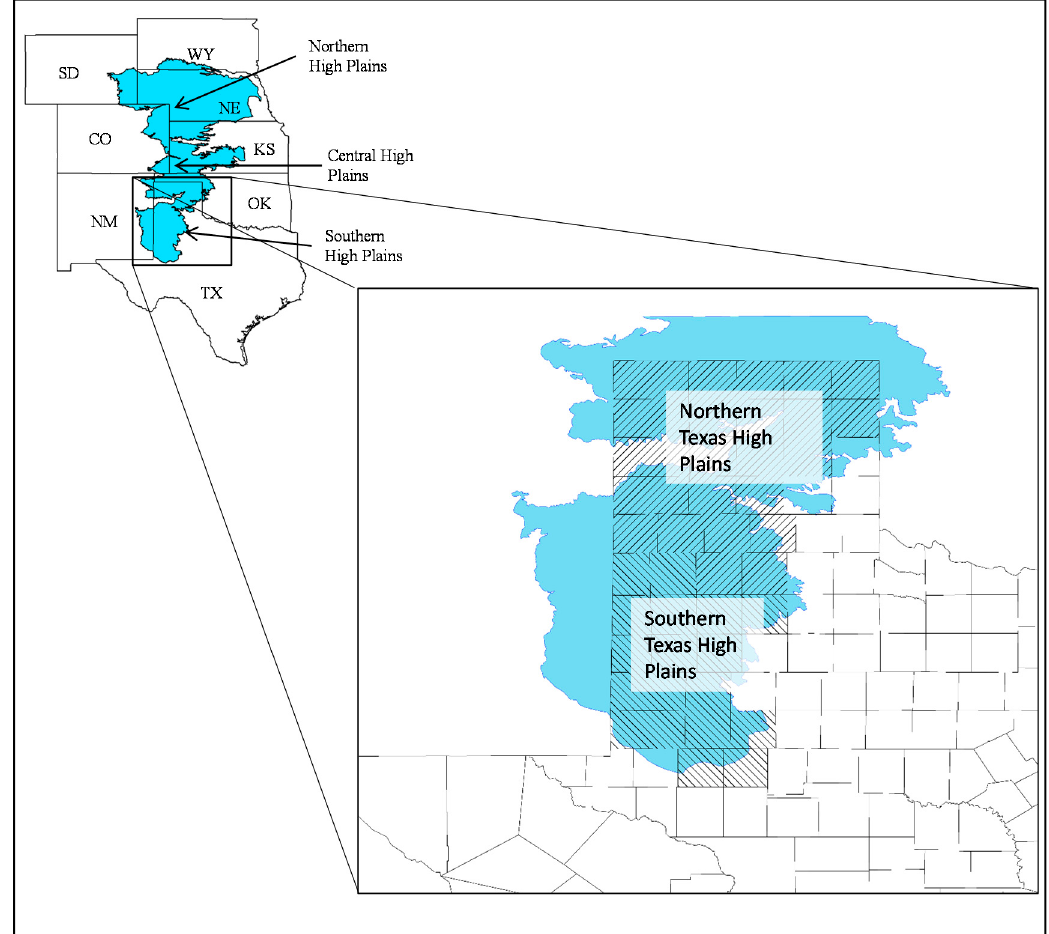
Figure 1. Ogallala Aquifer and Texas High Plains Regions.